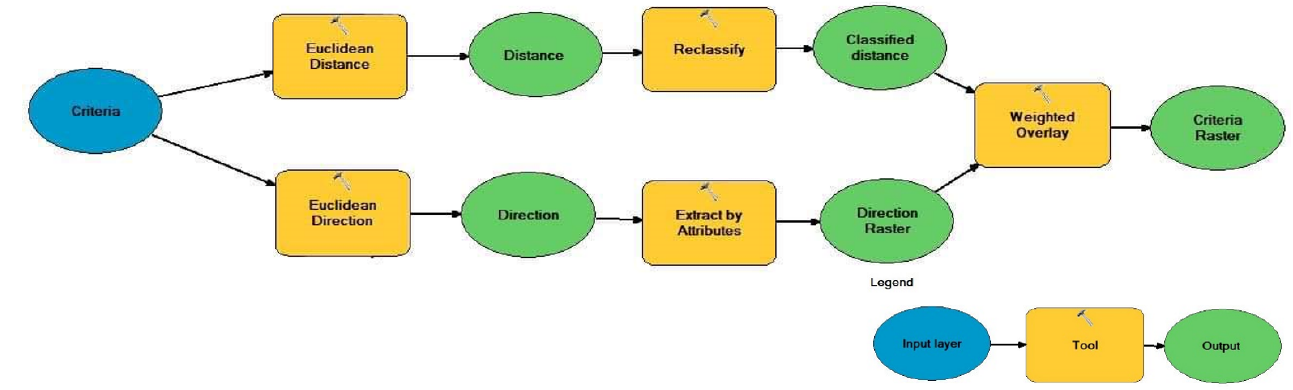
Figure 4. GIS model performed on each criterion.